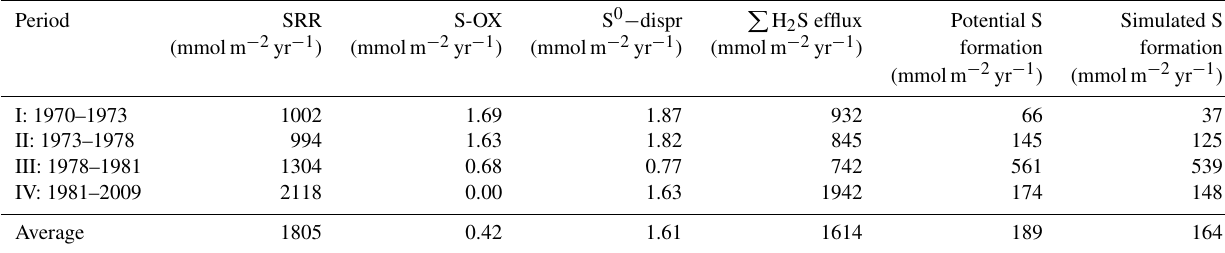
Table 3. Estimated depth-integrated SO 2 − reduction (SRR), S reoxidation (S-OX), and S 0 disproportionation rates (S 0 − dispr), as well 4